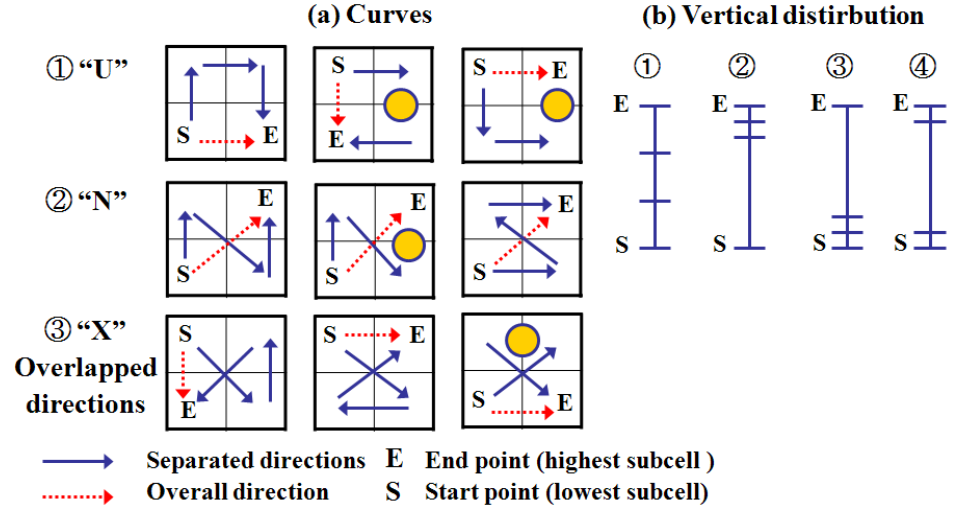
Figure 5. The relations of the separated directions of a surface slope.